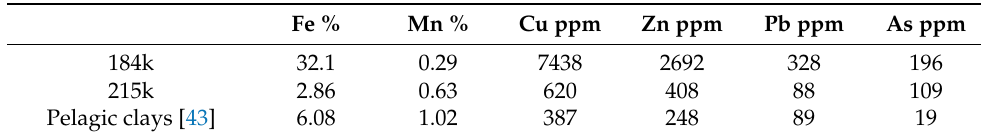
Table 2. Average contents of the ore metals (%, carbonate free base) in 184k and 215k in comparison to the pelagic clays